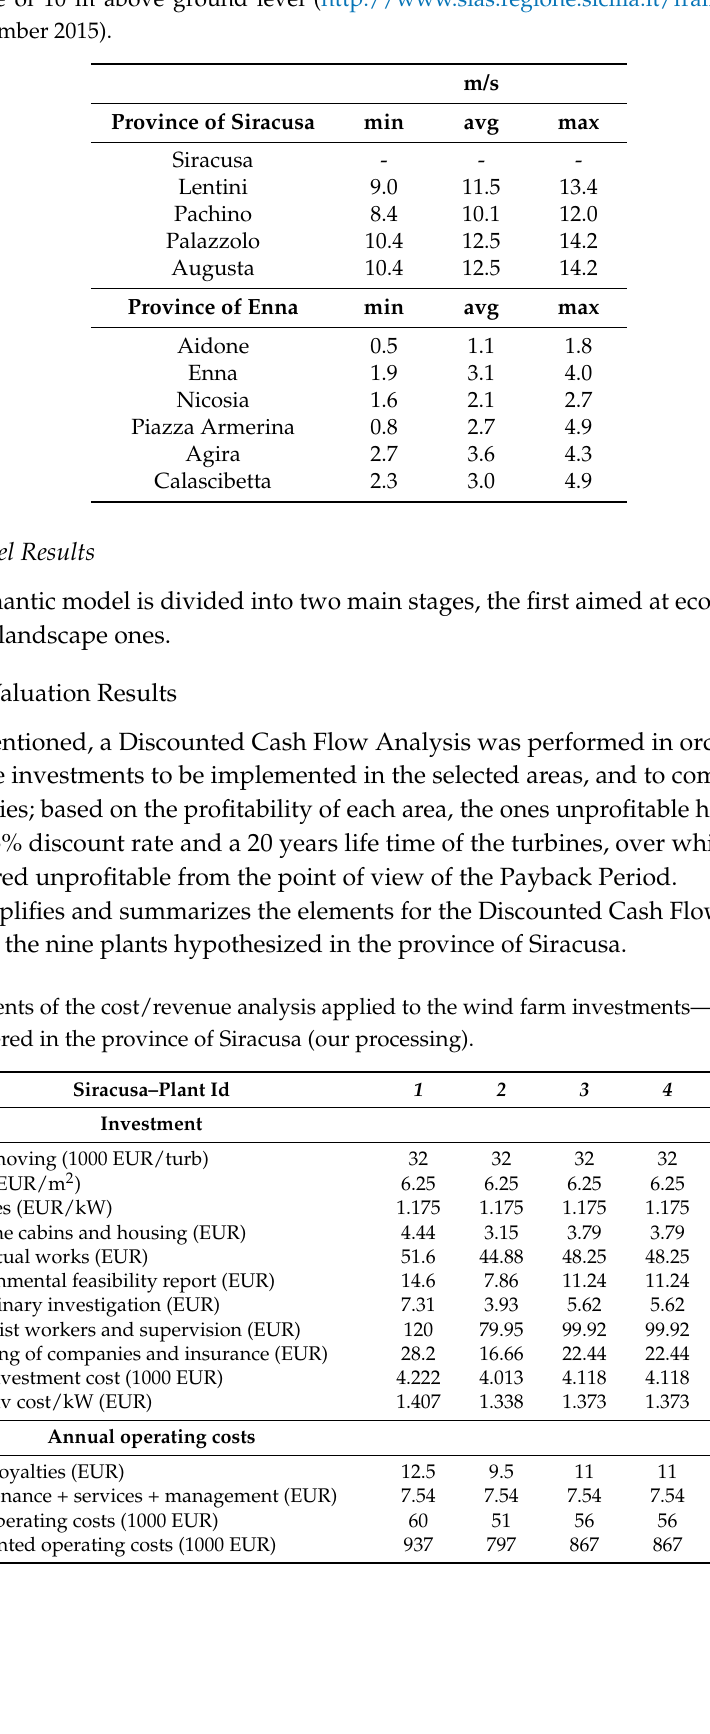
Table 1. Minimum, average and maximum anemometric measurements in the two provinces (at an altitude of 10 m above ground level (http://www.sias.regione.sicilia.it/frameset_dati.htm